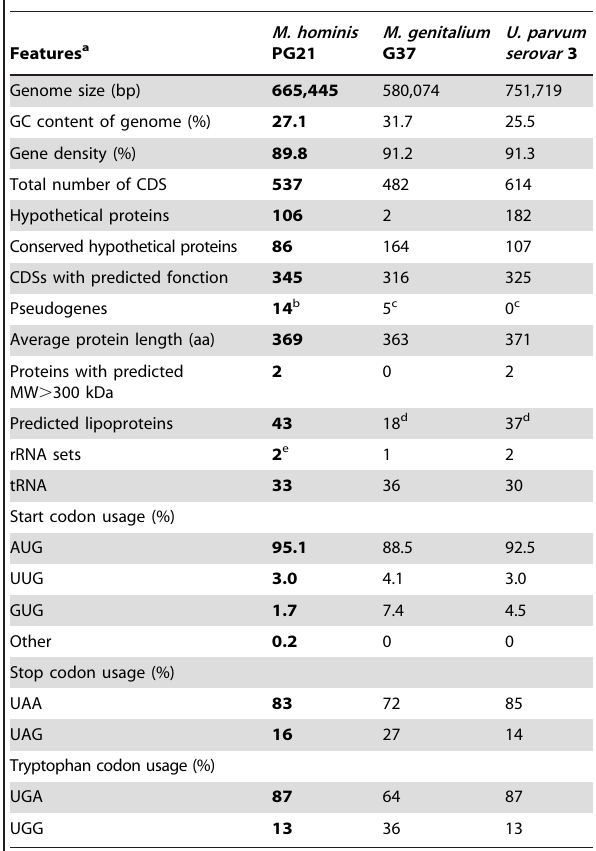
Table 1. Comparison of general features of the M. hominis genome with those of M. genitalium G37 (ATCC 33530) and U. parvum serovar 3 (ATCC